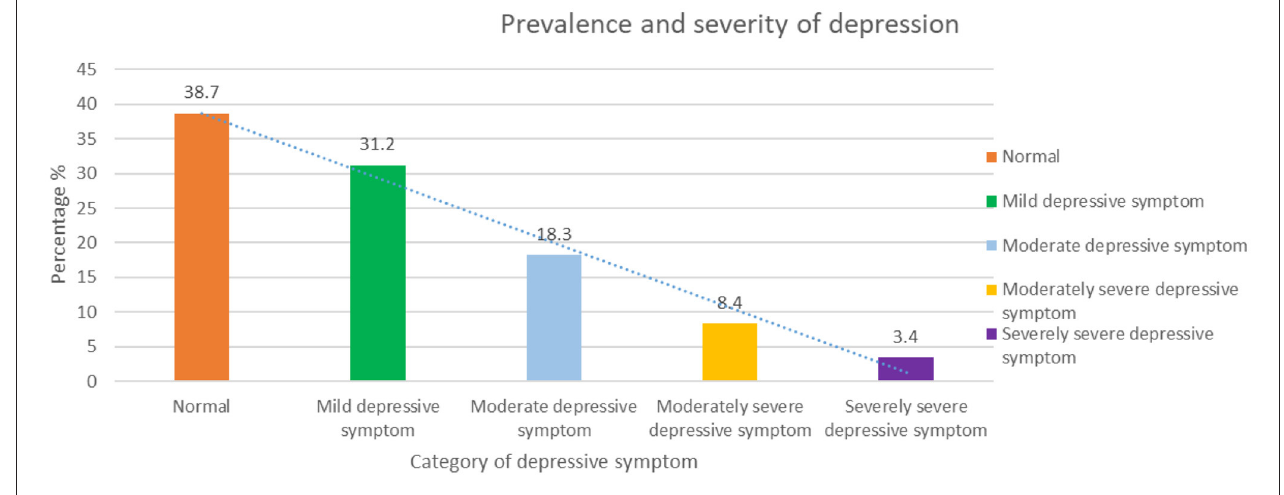
FIGURE 2 | Prevalence and Severity of Depressive